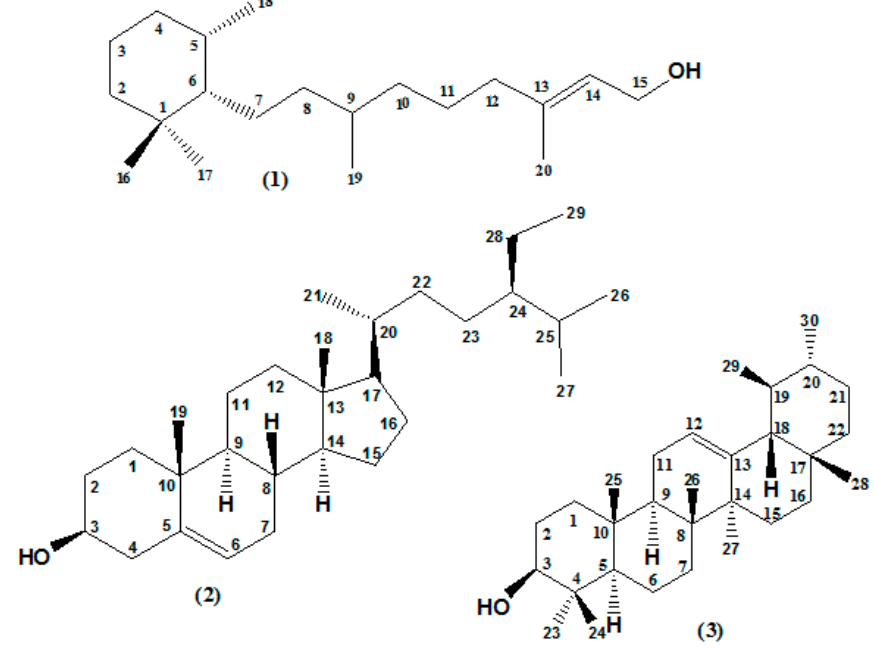
Figure 2. Structures of isolated bioactive terpenoids from P. rotundifolium . Cassipourol, β -sitosterol and α -amyrin (compounds 1 – 3 , respectively).